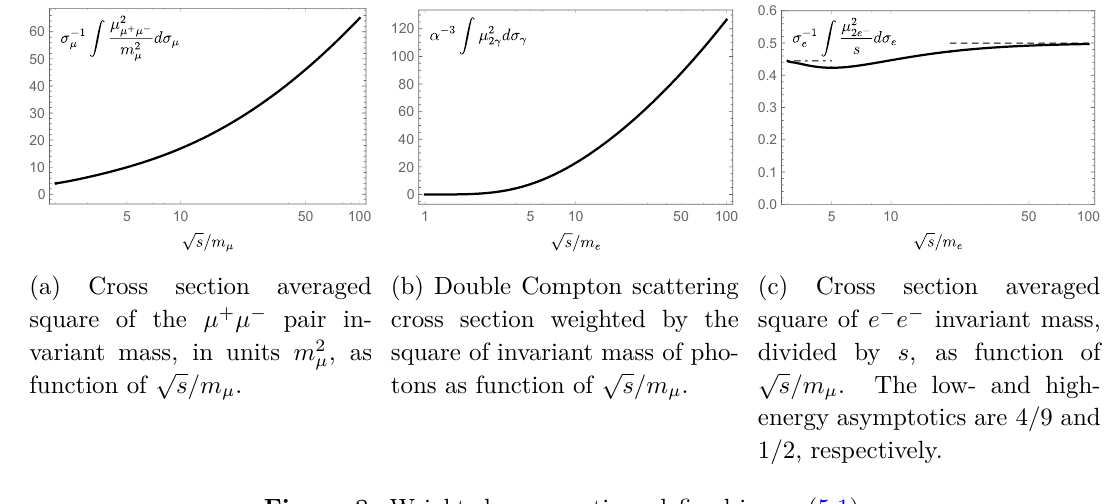
Figure 8. Weighted cross sections defined in eq.